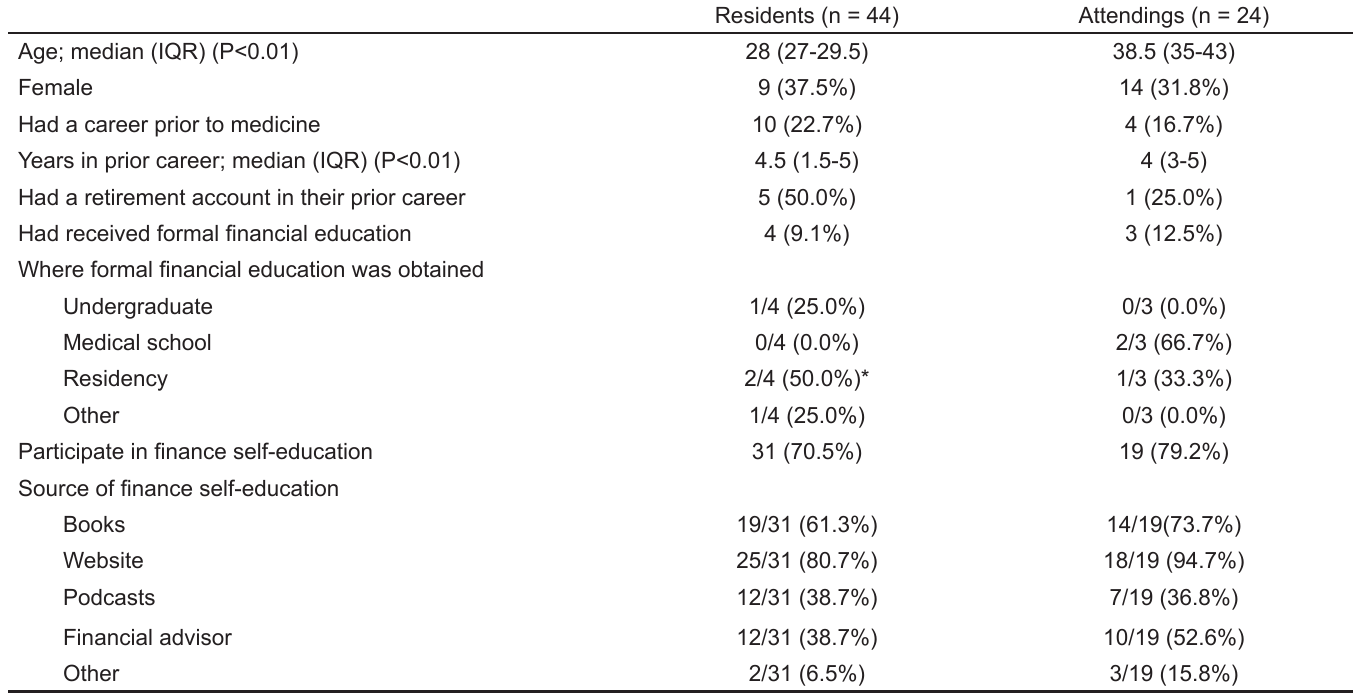
IQR , interquartile